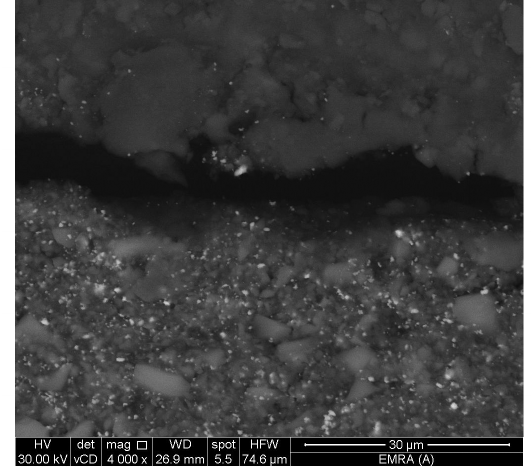
Figure 2. Selected scanning electron microscopy shows presence of gap formation in dentin for teeth treated with a self- adhering resin composite. Image representative of 8 teeth. Table 2. Chemical analysis of the interface between groups of teeth restored with self-adhering resin composite. Group A, treated with total- etch technique; Group B, treated with self-adhering resin composite. Mean and standard deviation (SD) values and results of Student’s t-test for the comparison between silver atomic % values are shown (n=8/group).